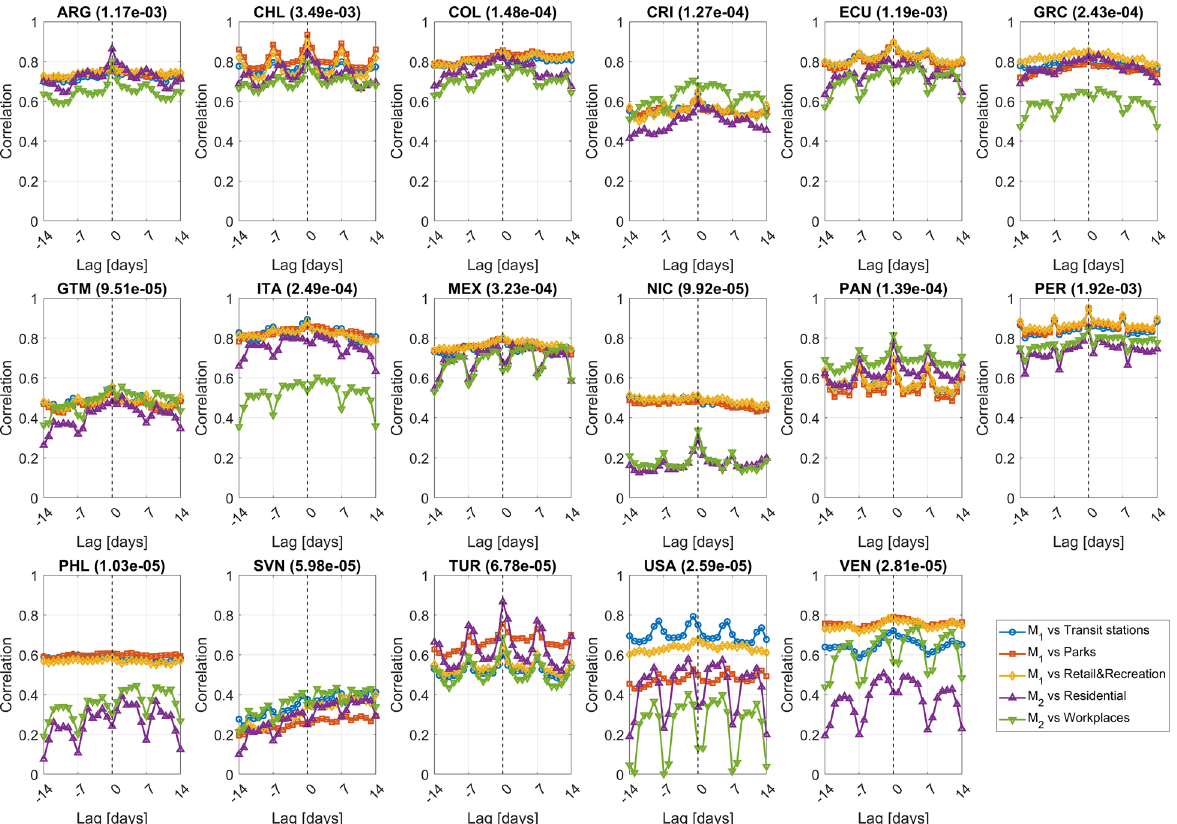
Figure 6. Time-shifted correlation graphs for correlations computed between the M 1 and M 2 metrics and the Google’s